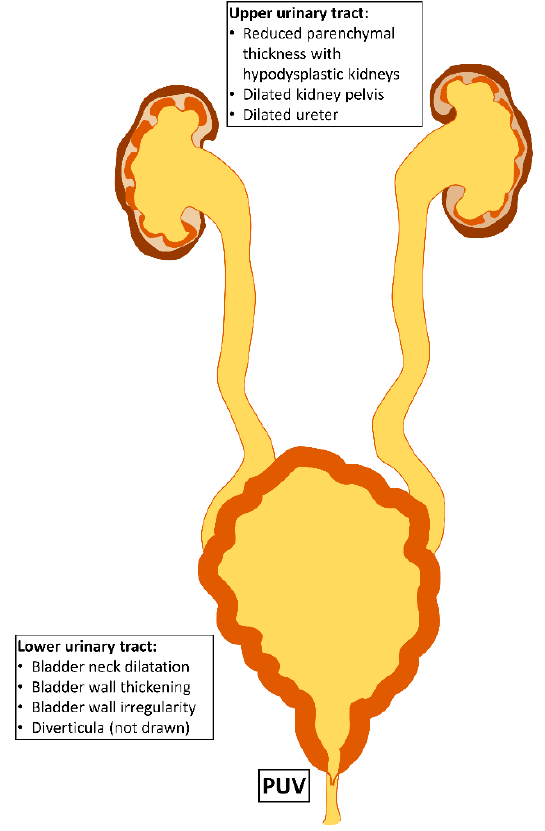
Figure 1. Alterations in the urinary tract due to posterior urethral valves. The subvesical obstruc- tion in the prostatic urethra by posterior urethral valves (PUV) leads to a bladder neck dilation and increased urethral resistance, with the need for increased voiding pressure. As a consequence, bladder wall hypertrophy develops with the morphologic hallmarks of wall thickening and wall irregularity, possibly with diverticula. The obstruction can reach the upper urinary tract and dilate the ureter and the kidney pelvis. The functional tissue of the kidney, the parenchyma, can be reduced in